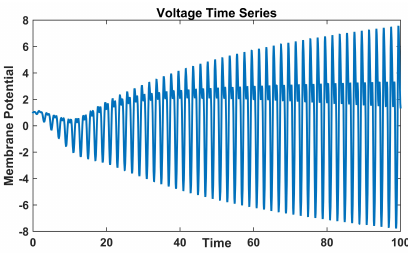
Figure 28. Recovery variable (right) with pa- rameter values a = 0.7, b = 1.5, c = 3